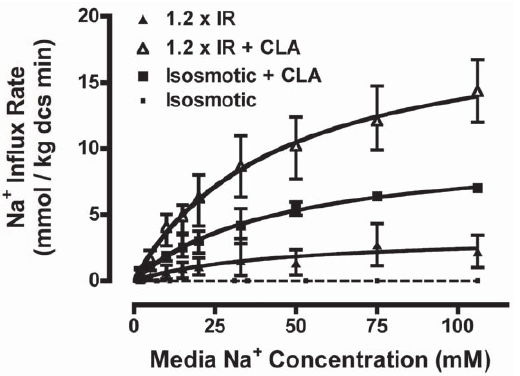
Figure 3. Na + transport kinetics of NHE1 in mildly hyperos- motic medium. The Michaelis-Menten Na + transport kinetics were determined for NHE1 in at RBCs following complete activation in mildly hyperosmotic (1.2 6 IR) medium alone (closed triangles), hyperosmotic (1.2 6 IR) medium with 500 nM CLA (open triangles), or CLA treatment alone in IR (squares). Data for resting atRBCs in isosmotic medium are shown for comparison (small squares, dashed curve). The data are fit by regression to a simple hyperbola, and the corresponding kinetic constants are reported in Table 2. The Na + transport affinity is not significantly different across the three conditions. However, the maximal transport rate J max is significantly increased in hyperosmotic media together with CLA treatment, relative to either treatment alone (p , 0.05). (data are compiled from n $ 3 independent experiments; means 6 SE).